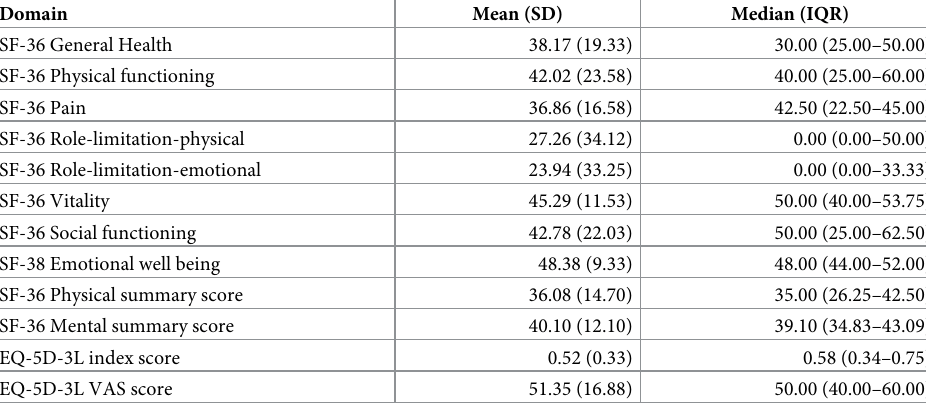
Table 3. QOL scores for domains of SF-36 and EQ-5D-3L.